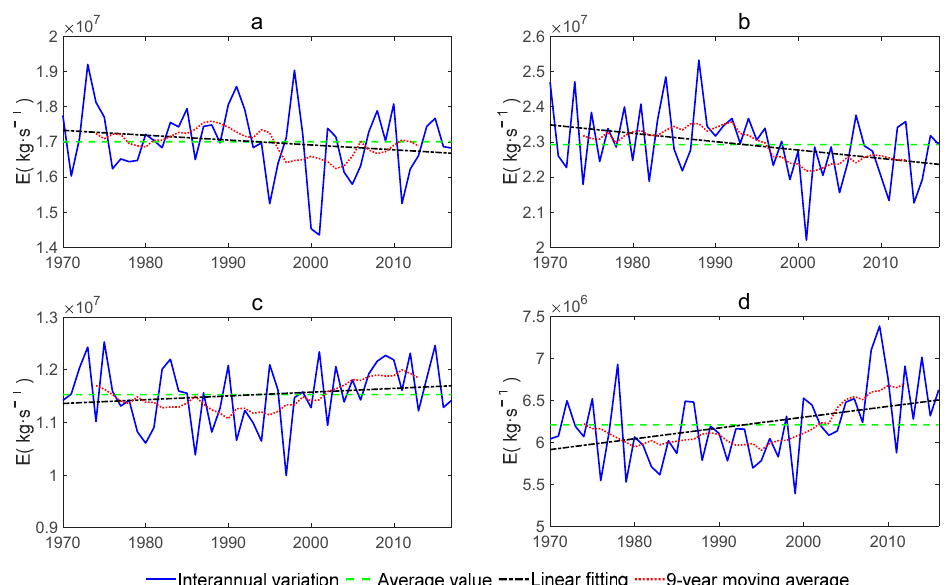
Figure 6. Interannual variation of evaporation in SAIE (semi-arid inland Eurasia) from 1970 to 2017 in ( a ) spring, ( b ) summer, ( c ) autumn, and ( d ) winter.